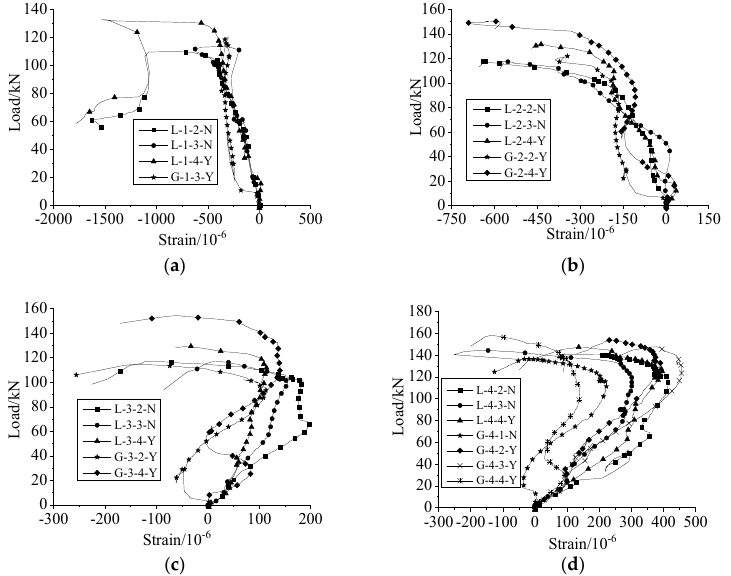
Figure 18. Load–longitudinal strain curves for the middle section of the sleeve near the steel bar under uniaxial tension and repeated high-stress tension and compression loading (the final tension process) (SZ3). ( a ) L = 6 d, ( b ) L = 8 d, ( c ) L = 10 d, ( d ) L = 12.5 d.